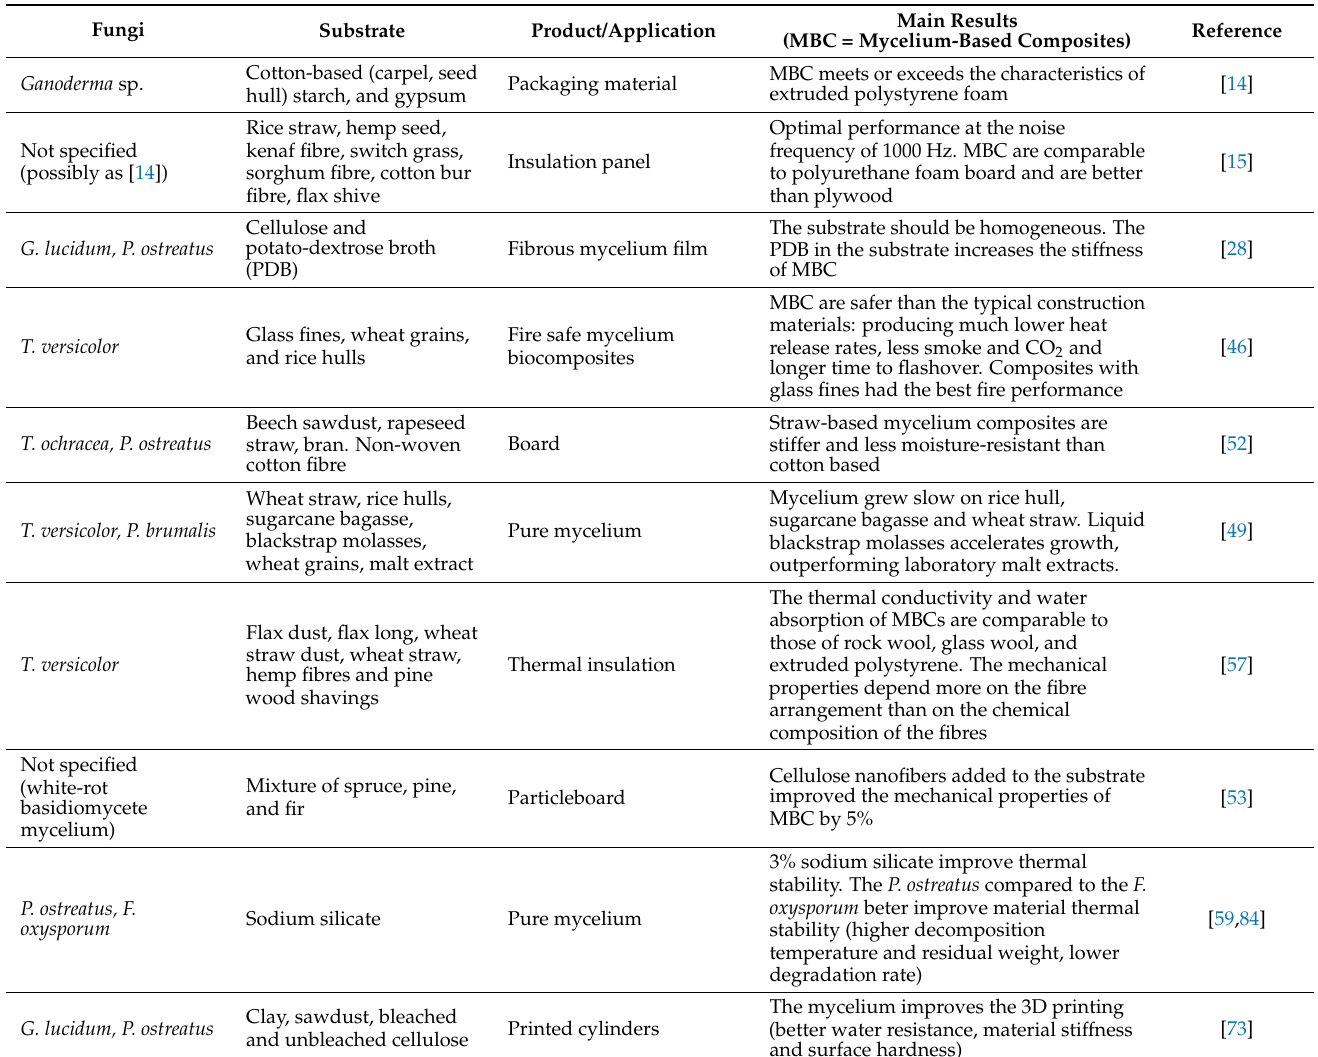
Table 2. Parameters and aims of mycelium-based composites production in scientific